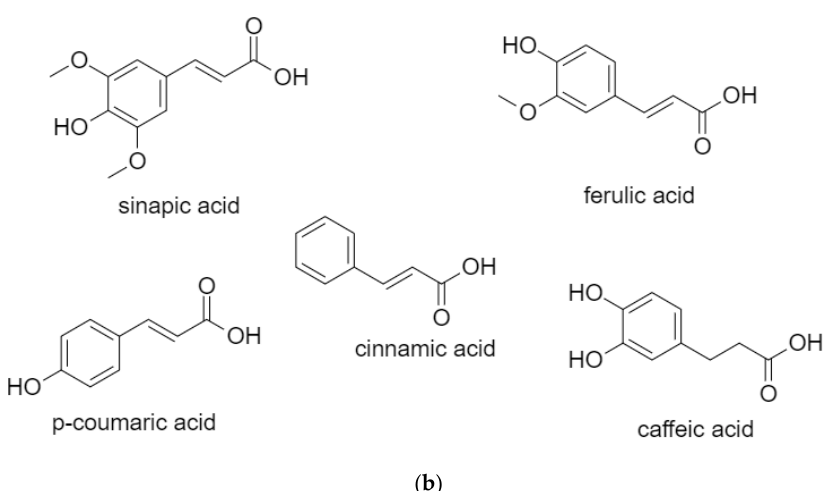
Figure 3. ( a ) Benzoic acids: vanillic, gentisic, protocatechuic, gallic, and syringic acid; ( b ) Cinnamic acids: caffeic, ferulic, p -coumaric, and sinapic acid.